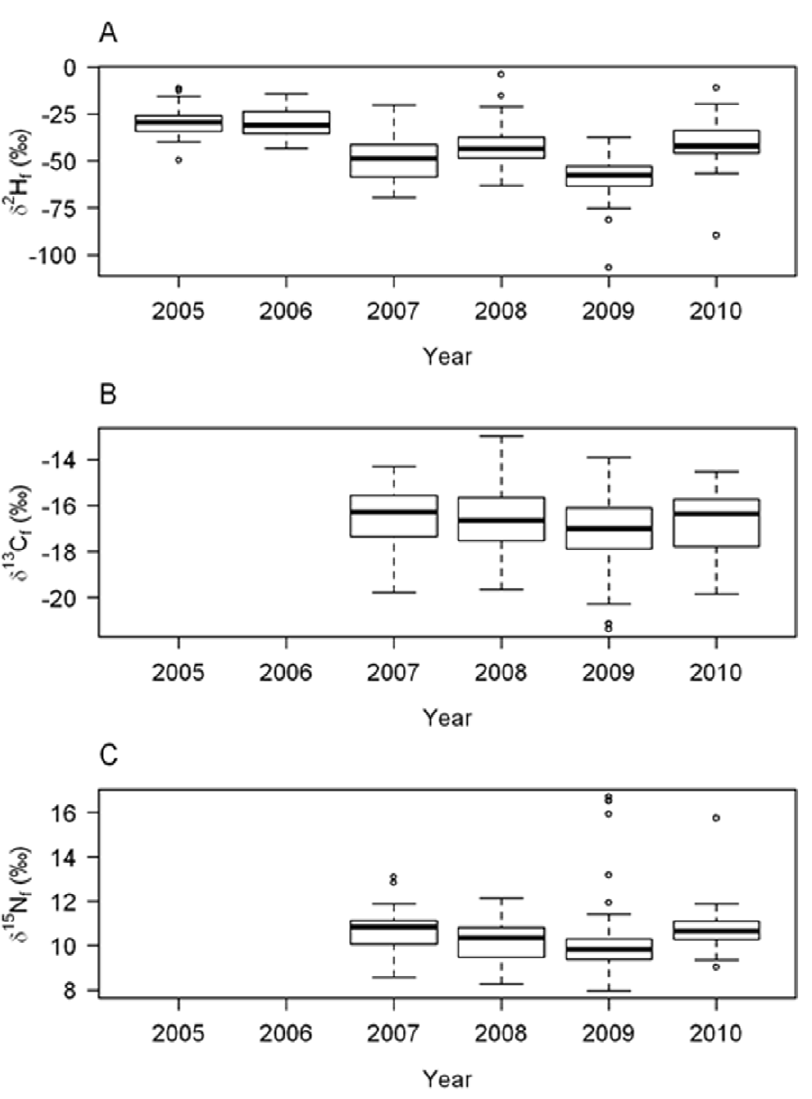
Figure 1. Variation in the isotopic composition of Aftrotropical grown house martin feathers from birds breeding in The Netherlands from 2005 to 2010 for A) d 2 H, B) d 13 C, C) d 15 N.